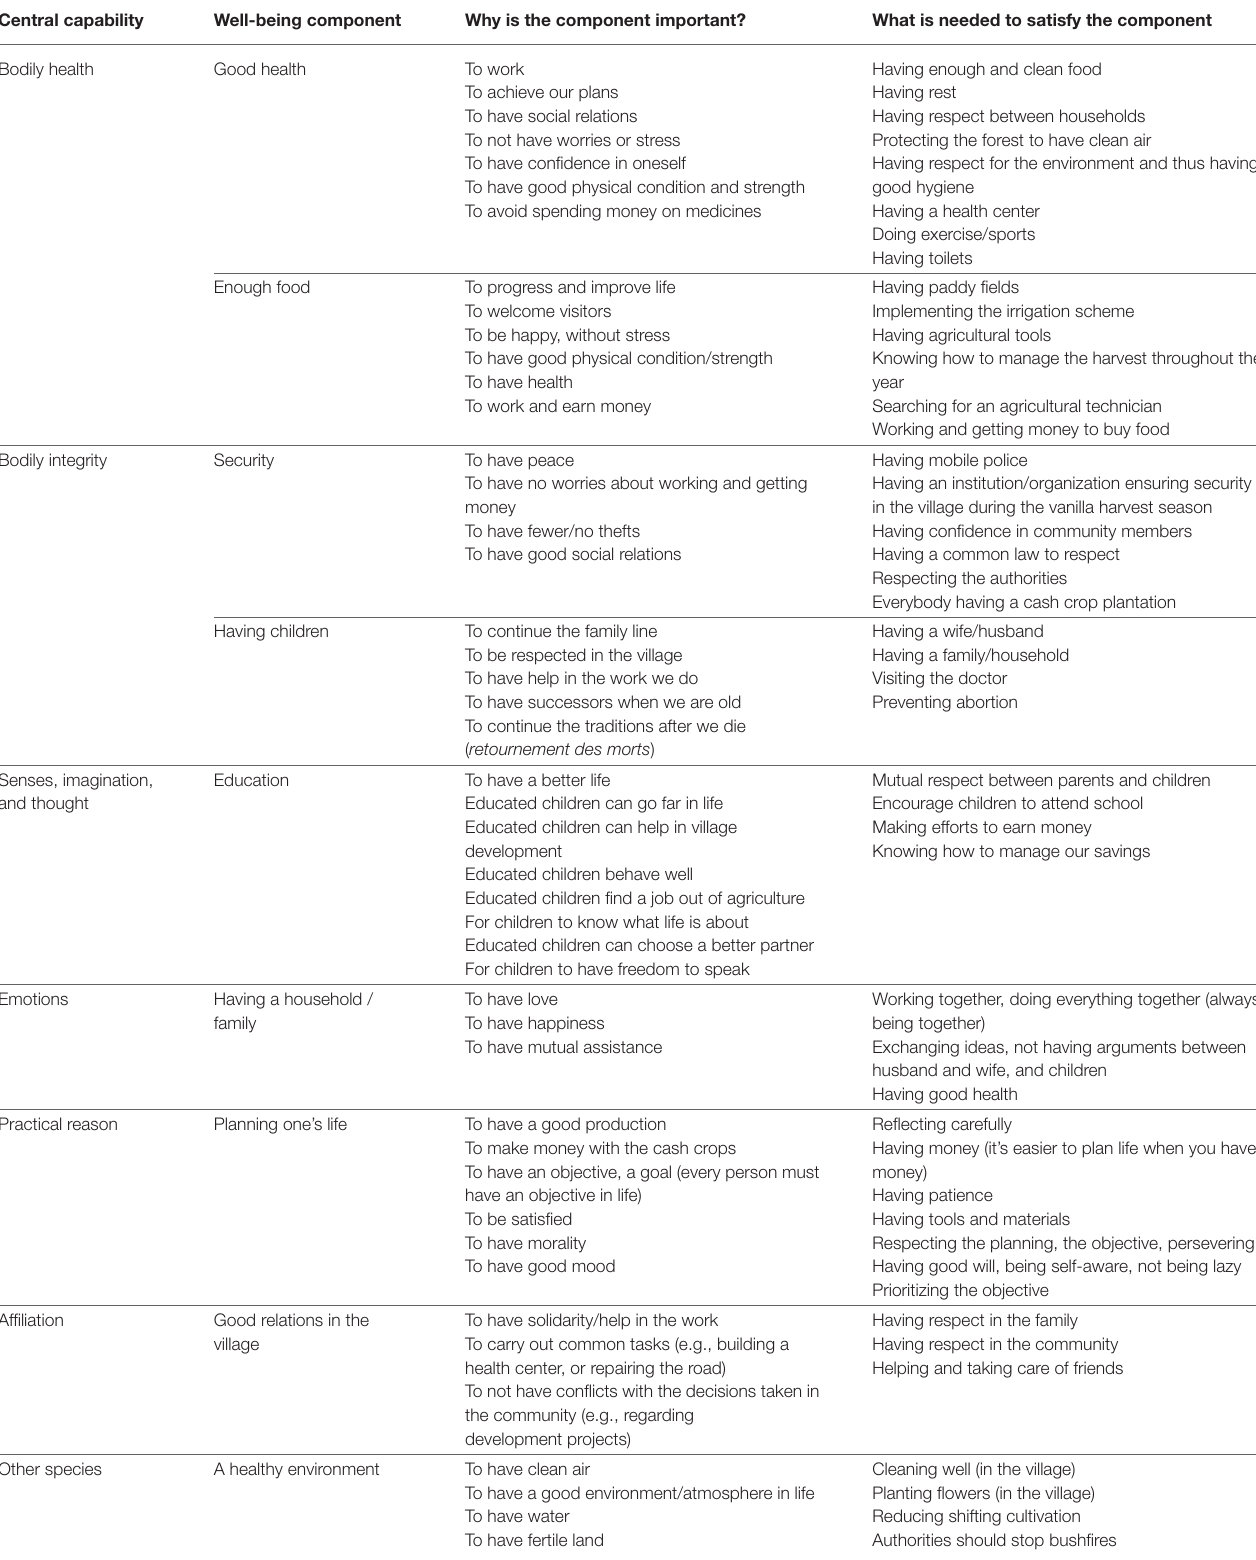
TABLE 3 | Central capabilities and well-being components: Examples provided during FGDs about their importance and what is needed to satisfy them. Central